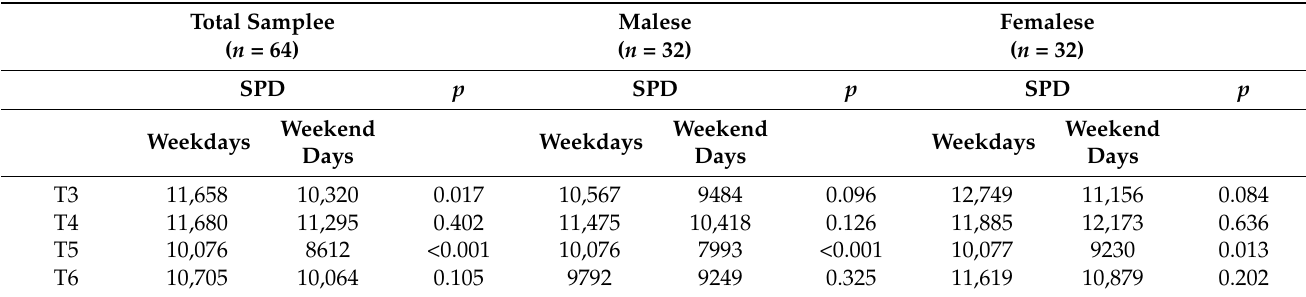
Table 3. The proportions of mean SPD during weekdays and weekend days from adolescence (T3, 2005) to adulthood (T4–T6, 2010–2020) in the total sample, and stratified by males and females,